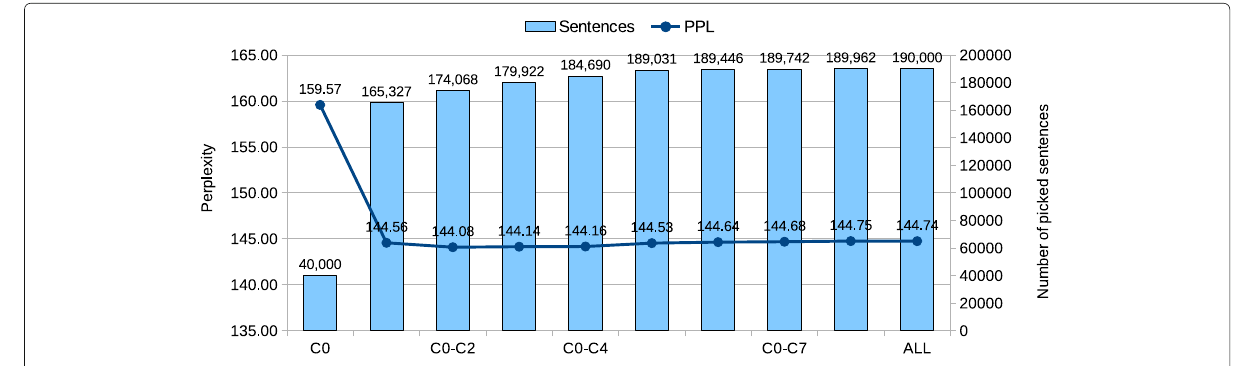
Fig. 4 Perplexities with accumulation of groups for CRF-based